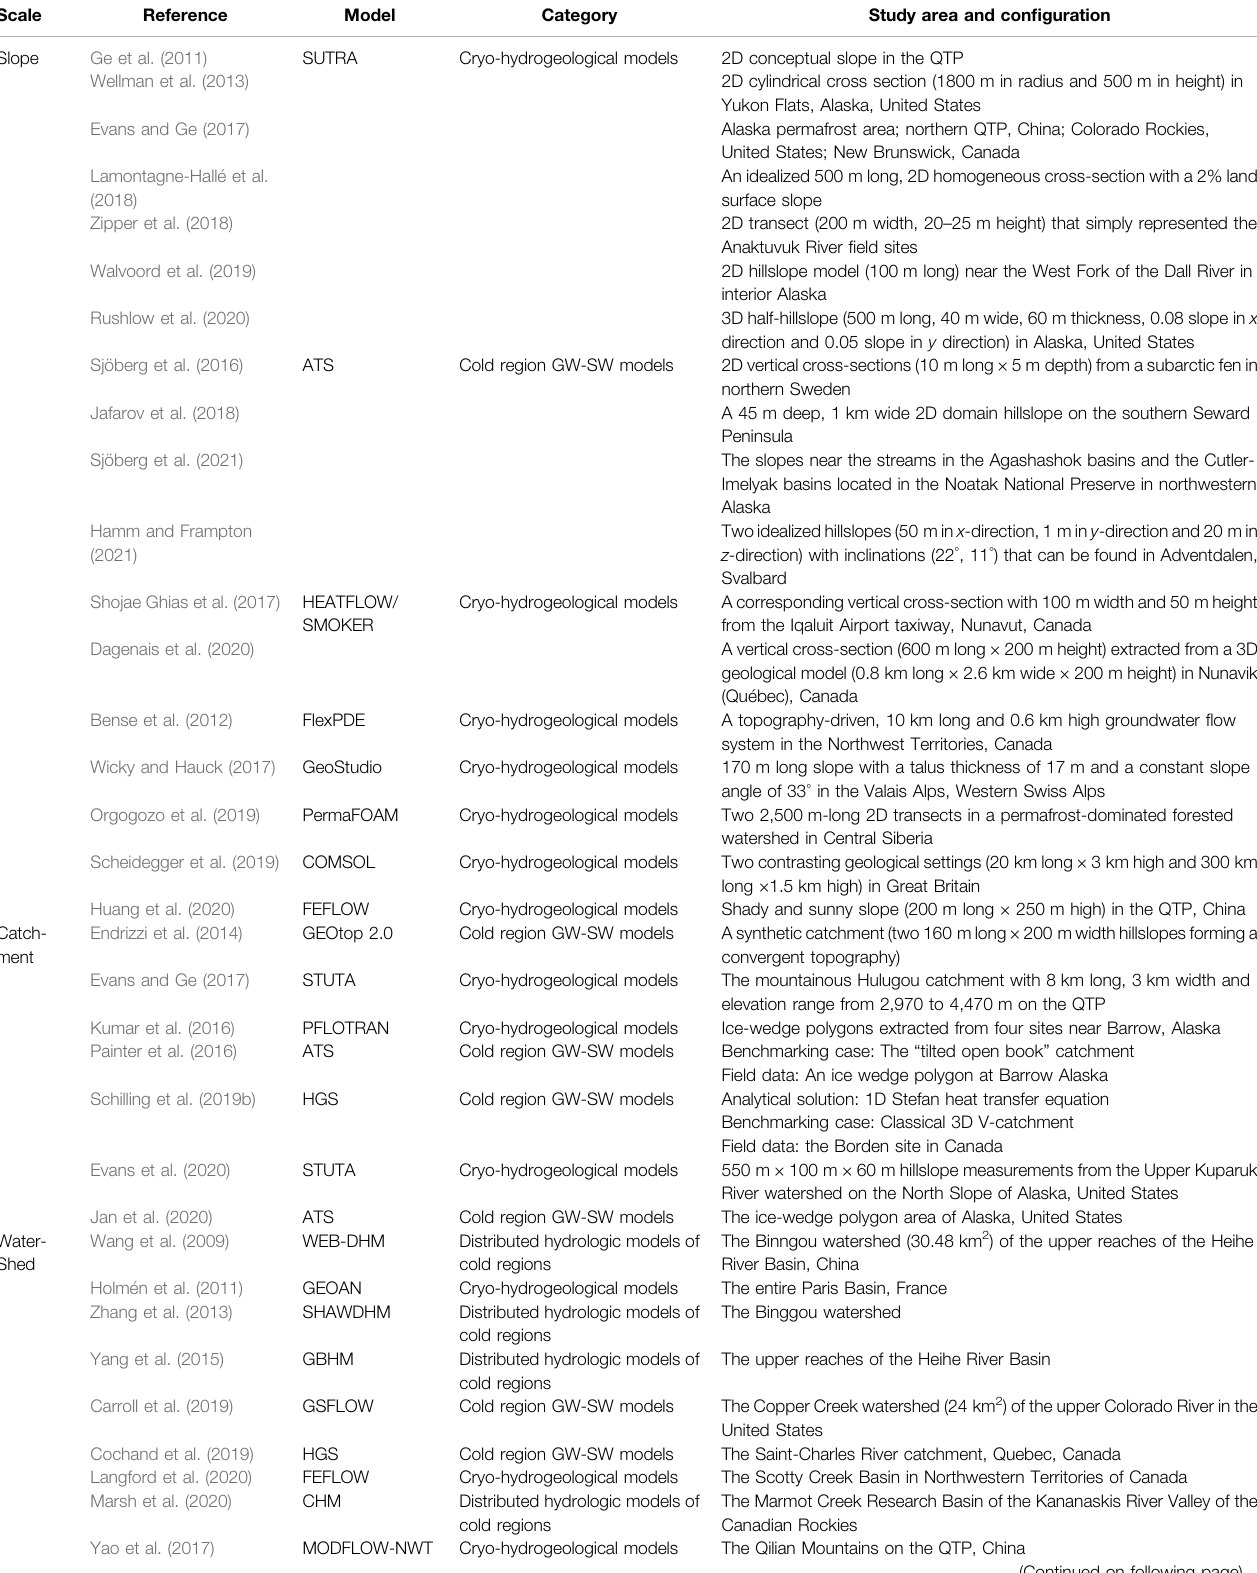
TABLE 3 | Summary of cold region integrated hydrologic models and their